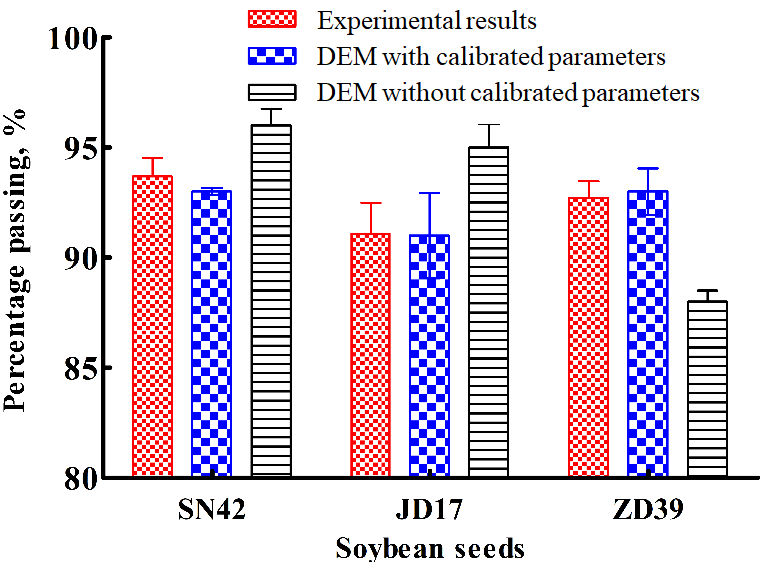
Figure 22. The percentage passing of the simulation and experimental results for three